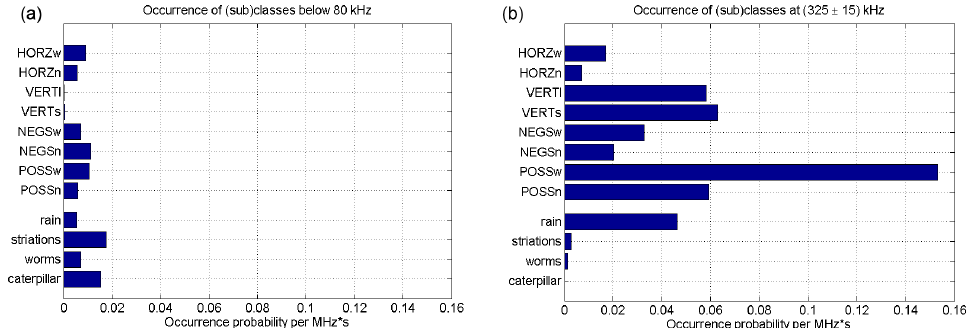
Figure 7. Two bar charts showing the occurrence probabilities per spectral area of 1MHzs of linear and special SKR fine structures for lower frequencies (below 80kHz) in (a) and for medium frequencies (around 325kHz) in (b)